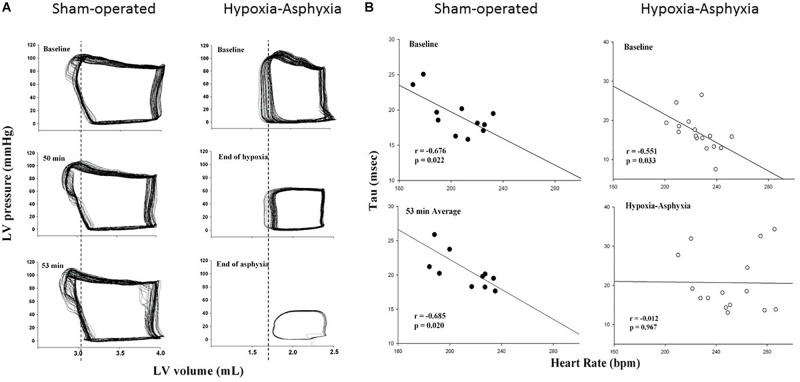
(A) Examples of pressure-volume loops of left ventricle (LV) measured by the Millar® catheter during the experiment of a sham-operated and a hypoxia-asphyxia (HA) newborn piglet. Vertical lines, which represented the isovolumetric relaxation phase at the respective baseline of the sham-operated and HA newborn piglet, are drawn and pass through the loops of respective animals at subsequent time-points during the experimental period for comparison. (B) Correlation between heart rate and Tau in sham-operated and HA groups at baseline (upper panels) and during 53 minutes of normoxia or HA (lower panels).